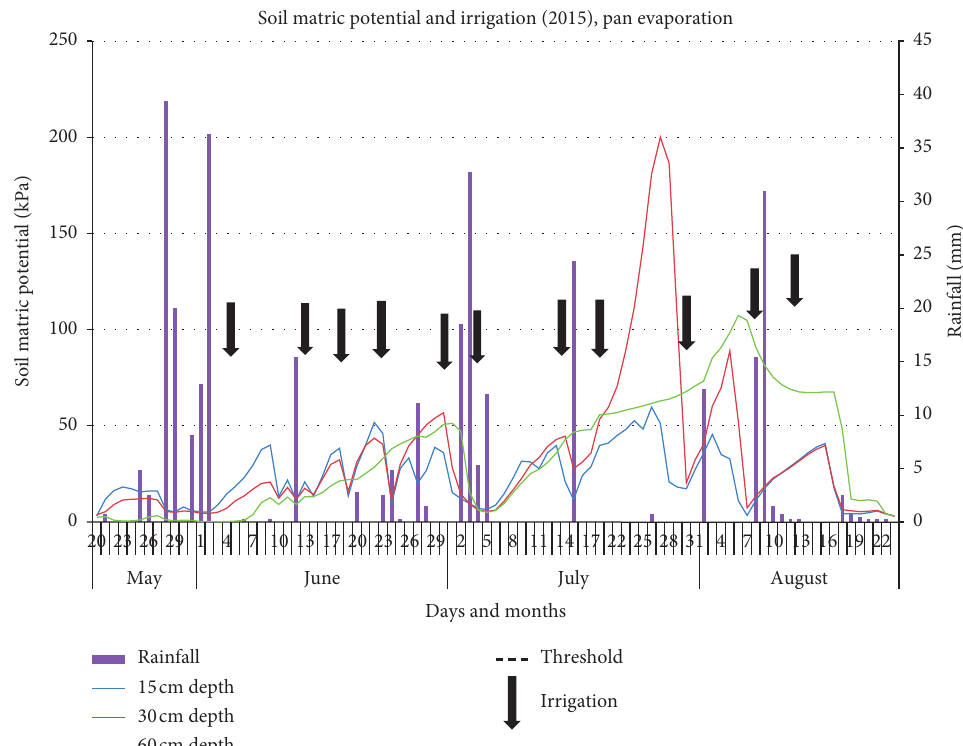
Figure 2: Daily soil matric potential in the pan evaporation plot fertilized with 269kg N ha − 1 in 2015 at TVREC. The amount of irrigation referred to in the black arrows was value between 15 and 25 mm to avoid runoff.